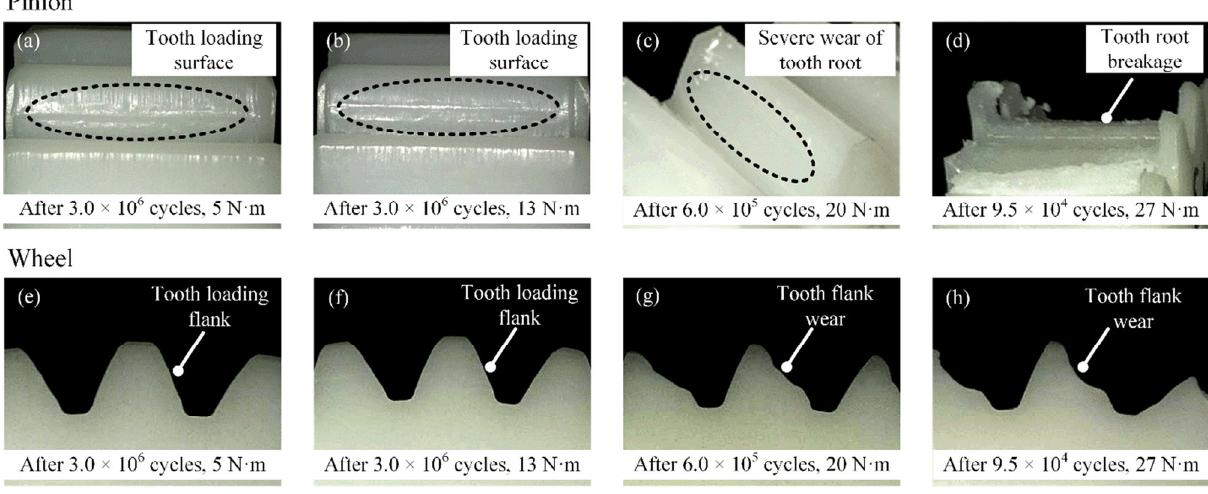
Fig. 5 Tooth damages under the dry running